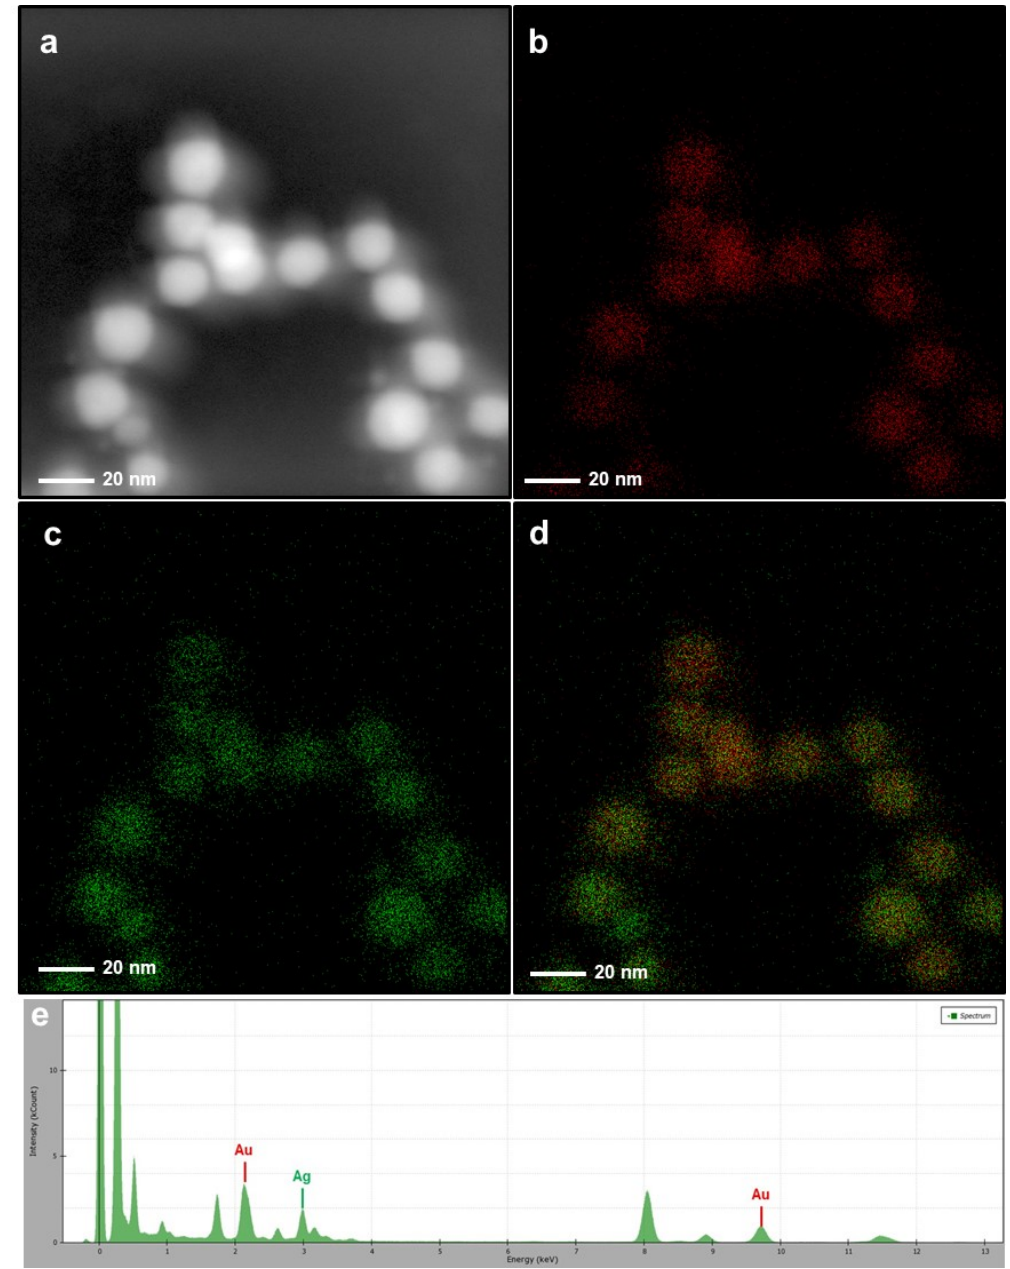
Figure 6. Elemental mapping and EDAX spectrum of the AuNP@30PDOP@60AgNP system. Electron micrograph region ( a ), distribution of gold elemental mapping ( b ), distribution of silver elemental mapping ( c ), overlay of gold and silver ( d ), and relevant EDX spectrum ( e ).